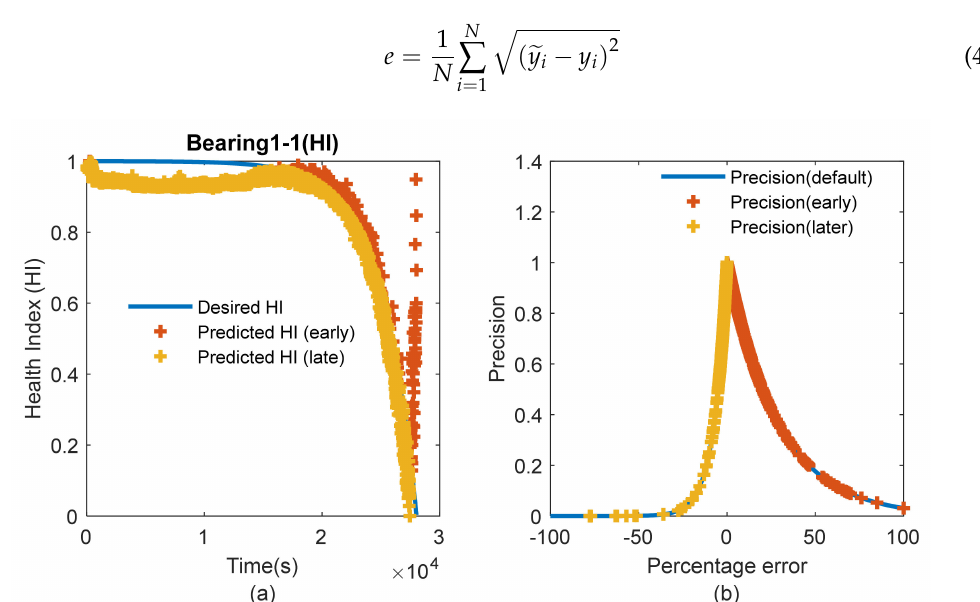
Figure 9. Applying PHM 2012 accuracy formula on HI curve fit: ( a ) HI curve fit with ML linear model; ( b ) Predictions distributions according to PHM 2012 accuracy